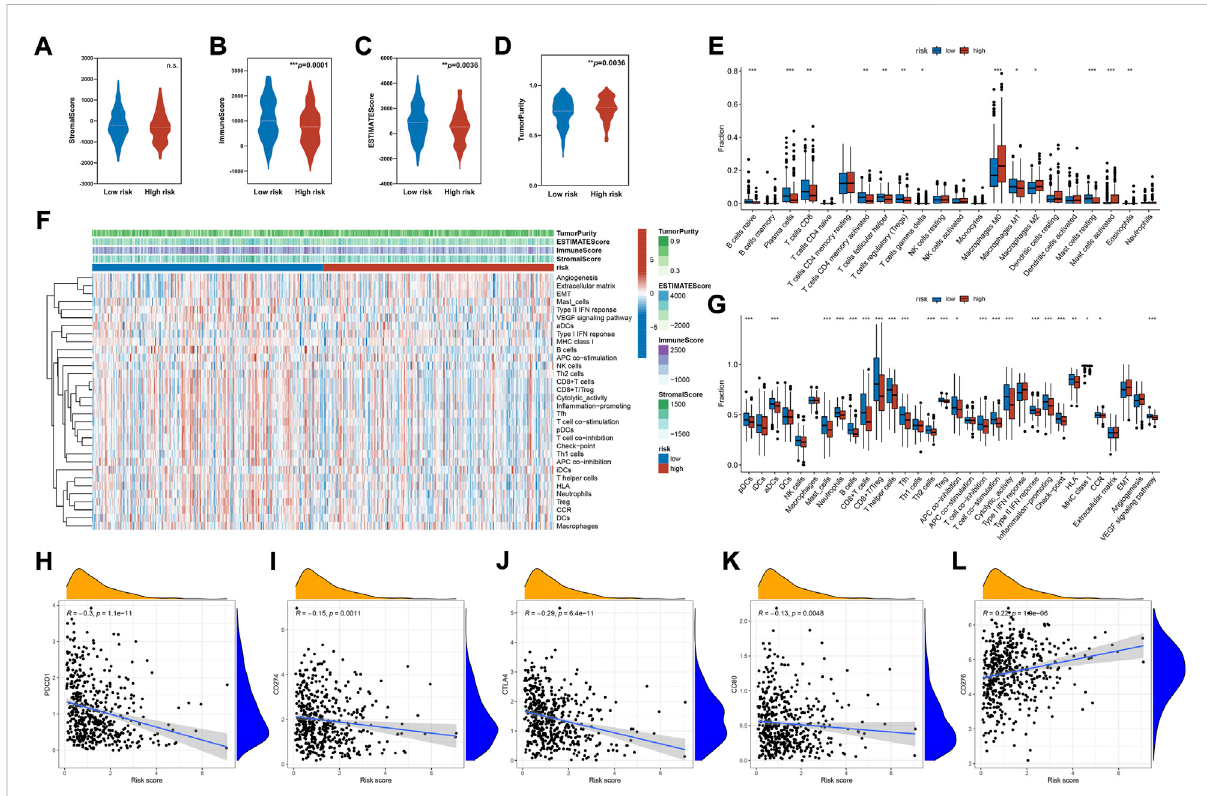
FIGURE 5 Immune cells in fi ltration and functional analysis. (A – D) The analysis of the stromal score, immune score, ESTIMATE score, and tumor purity between the high- and low-risk groups. (E) Immune cell subpopulations analysis between the high- and low-risk groups based on CIBERSORT algorithm. (F) Heatmap of the enrichment score of immune cells subpopulations and immune-related pathways signatures based on ssGSEA algorithm. (G) Differential enrichment analysis of immune cells subpopulations and immune-related pathways between the high- and low-risk groups based on ssGSEA algorithm. (H – L) Scatter plot of correlations between representative immune checkpoint expression and risk score. Data were analyzed using Spearman ’ s correlation method. * p < 0.05, ** p < 0.01, *** p < 0.001, **** p <